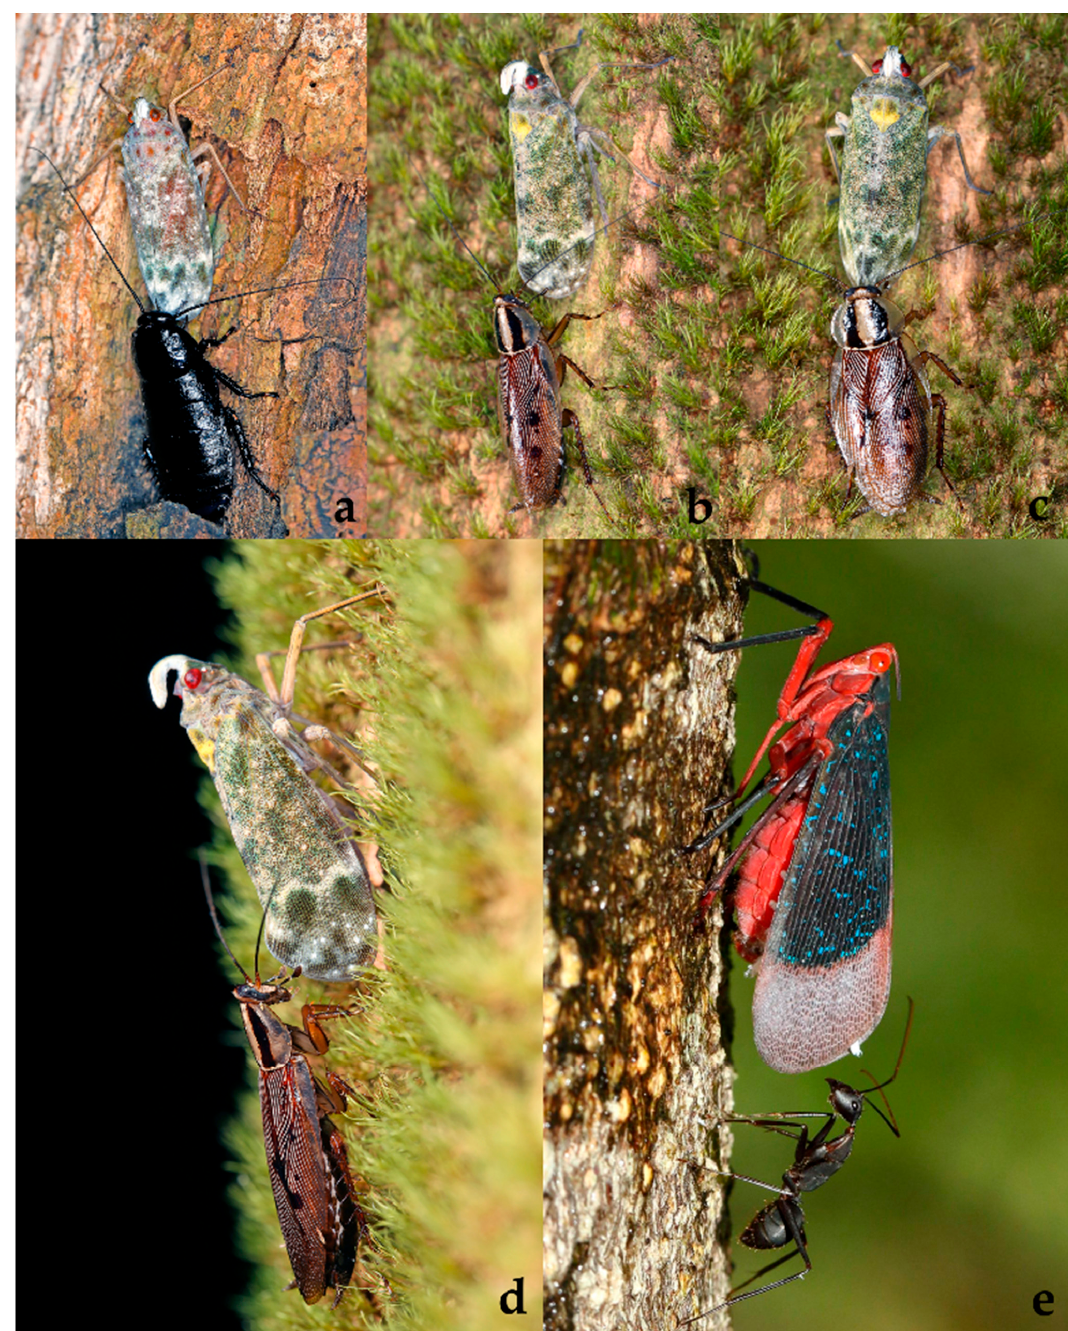
Figure 9. Fulgoridae: ( a ) Enchophora sp. tended by Blattodea: Blattidae: Eurycotis sp., Costa Rica: Puerto Viejo de Sarapiquí, La Selva Biological Station, 10°25 ′ 42.54 ″ N 84°0 ′ 26.68 ″ W, 70 m, 03.02.2014, adult on tree trunk, obs. G. Kunz; ( b – d ) Enchophora sp. tended by Blattodea: Ectobiidae: Macrophyllodromia maximiliani (Saussure, 1873), Costa Rica: Puerto Viejo de Sarapiquí, La Selva Biological Station, 10°25 ′ 54 ″ N 84°0 ′ 38.60 ″ W, 65 m, 09.02.2018, adult on tree trunk, obs. G. Kunz; ( e ) Kalidasa lanata (Drury, 1773) tended by Formicidae indet., India: Karnataka, 12°58 ′ 12 ″ N 77°30 ′ E, 07.2017, adult on tree trunk, obs. A. C. Deodhar.